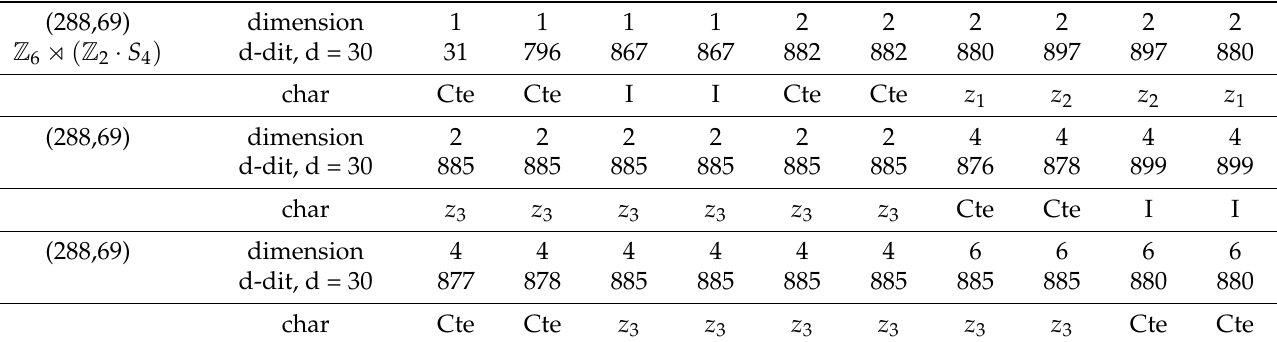
Table 1. For the group G 6 : = ( 288,69 ) ∼ = Z 6 (cid:111) 2 O , the table provides the dimension of the representation, the rank of the Gram matrix obtained under the action of the 30 -dimensional Pauli group and the entries involved in the characters. All characters are neither faithful nor informationally complete. The notation is I = exp ( 2 i π /4 ) , z 1 = z 3 = − 2 cos ( π /9 )